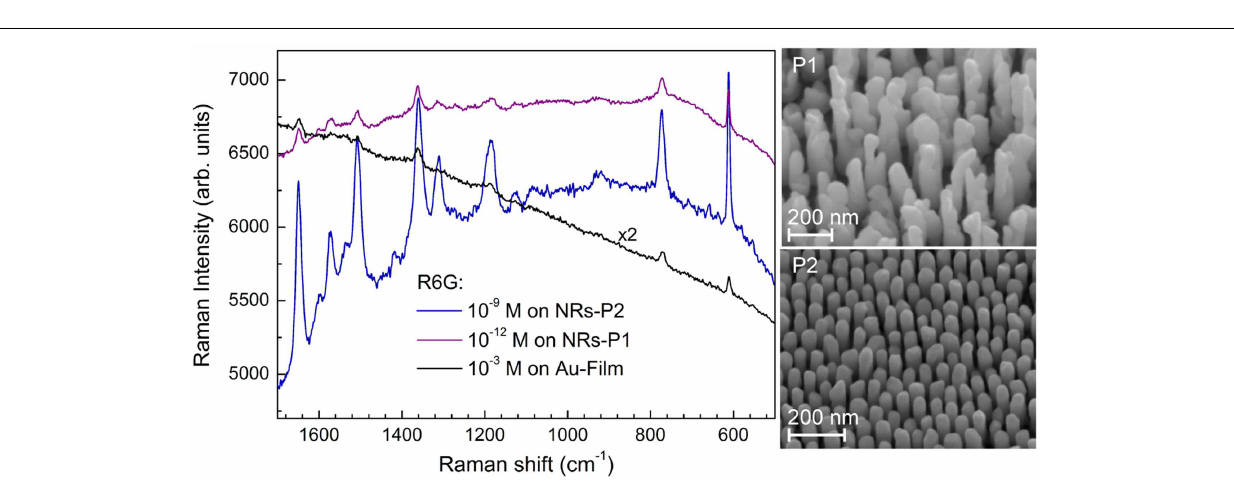
FIGURE 11 | Morphology effects of supportedAu-NR on the SERS signal of R6G .The SERS signal on P1 (corrugated morphology) is reproducible over the whole substrate while that of P2 (smooth morphology) is obtained only on isolated areas (Habouti et al., 2011b).The SEM micrographs of both morphologies are shown on the right-hand